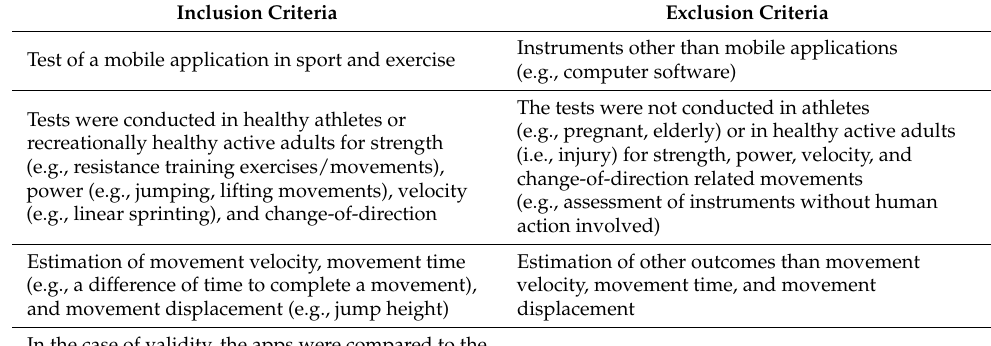
Table 1. Eligibility